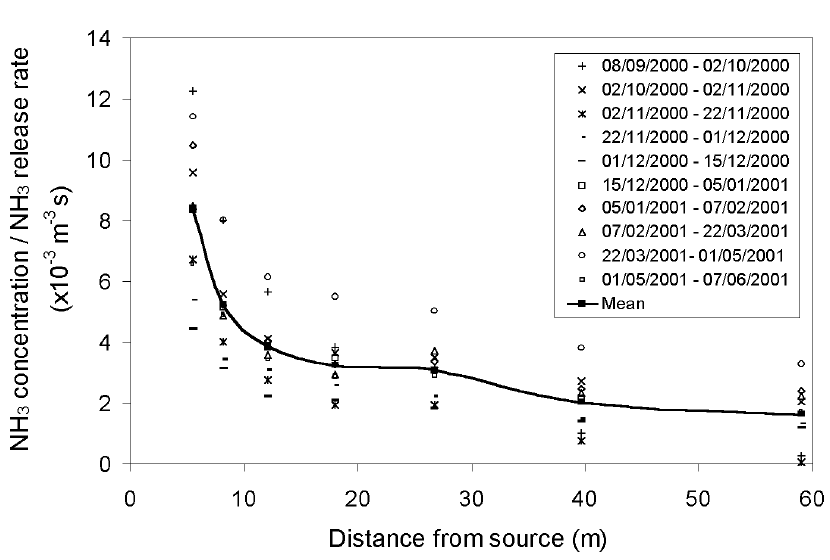
FIGURE 4. Normalised mean ammonia concentration profiles measured using the passive (ALPHA) samplers for all sample periods.